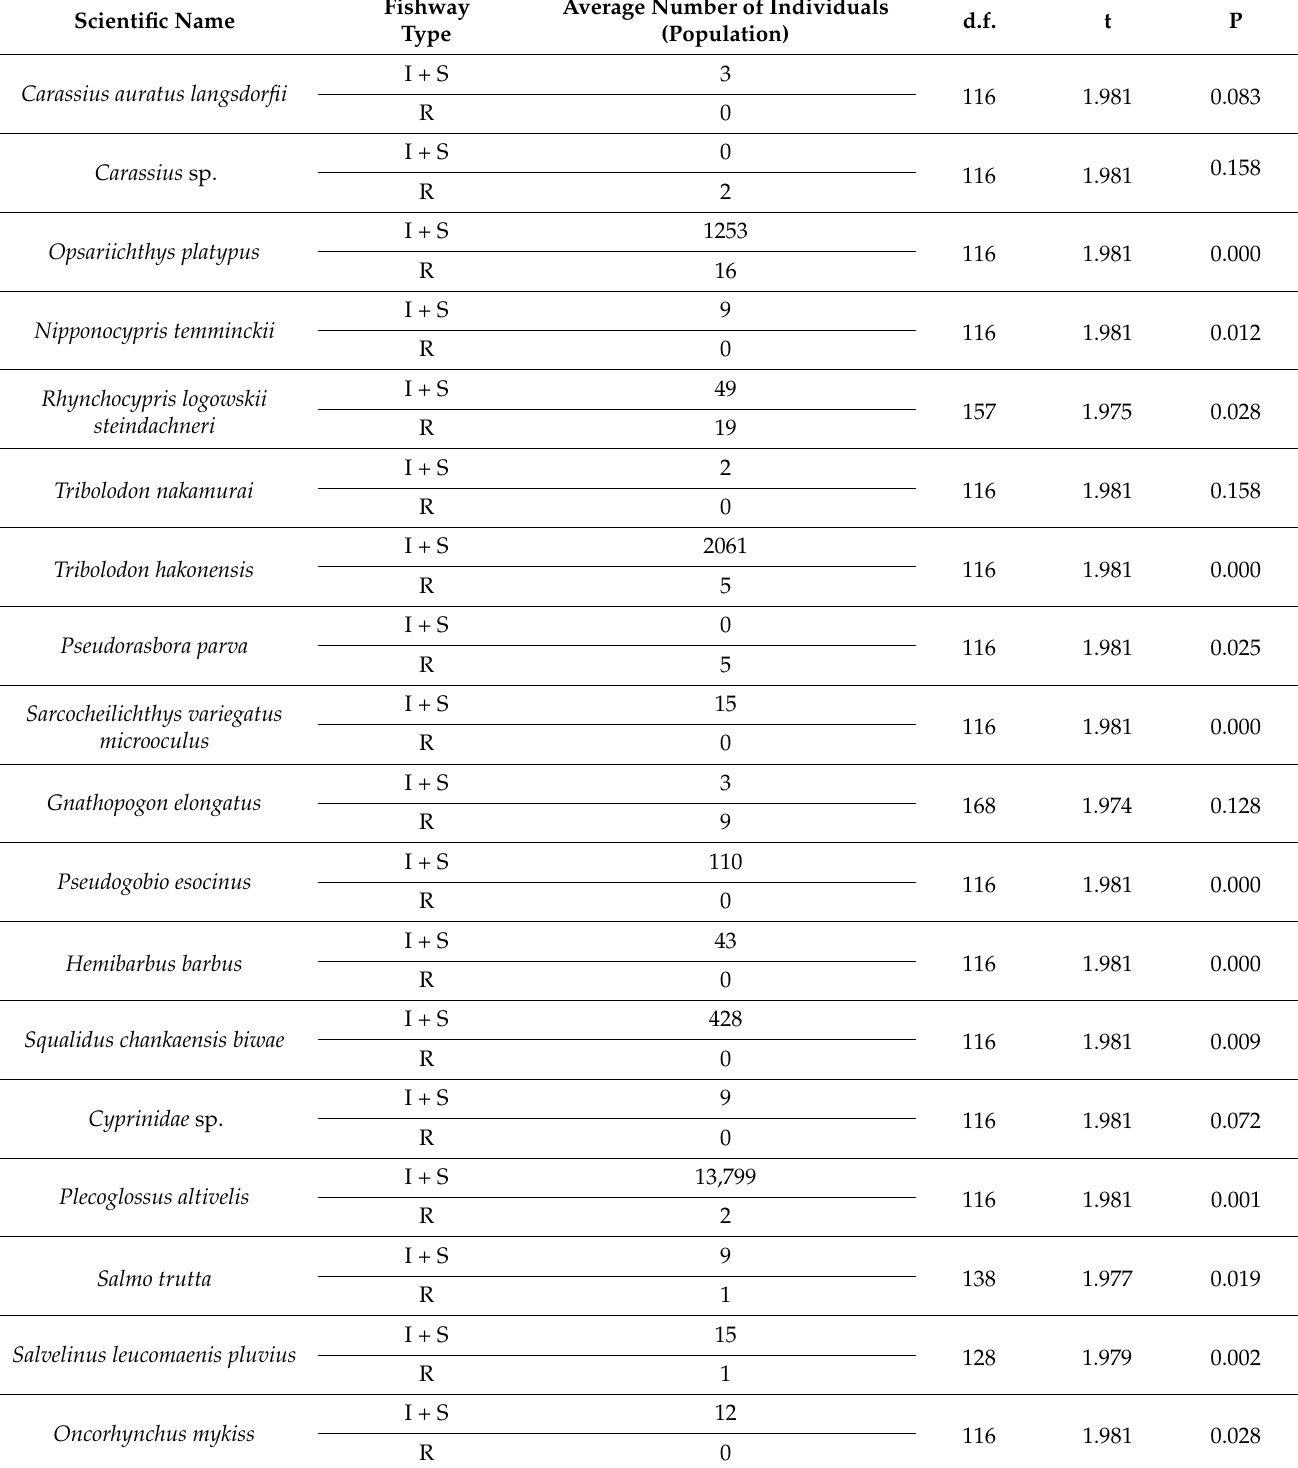
Table 8. Results of capture surveys in each fishway for four years (2012–2015) after the new rock-ramp fishway was established. The number of captured individuals shows the average value for 4 years. (Ice-harbor and stair-type fishways: I + S, rock-ramp fishway: